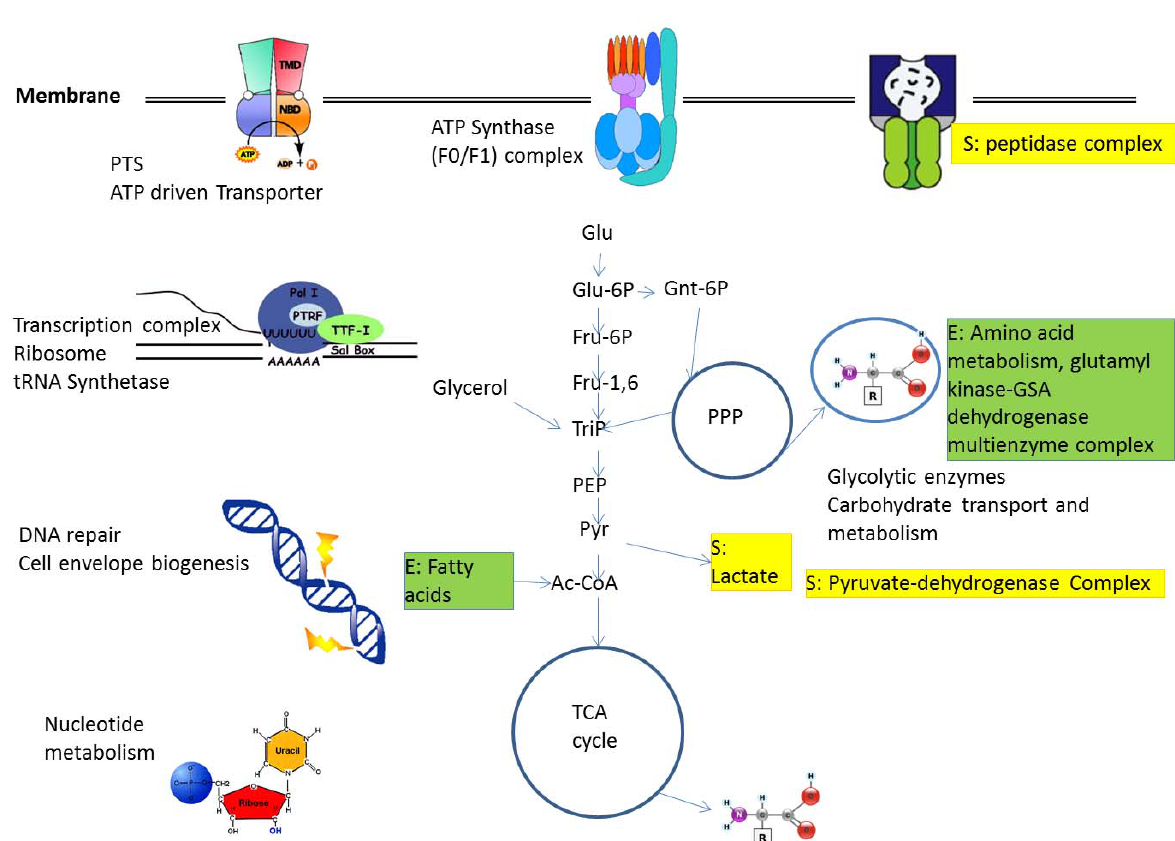
Figure 2. Protein complexes and their connection with metabolism. A number of central complexes are shown, giving the situation in E. coli , as well as implied and connected central metabolic pathways. In S. aureus , details of several complexes differ ( E. coli -specific complexes not present in S. aureus are labeled with E (in green), S. aureus -specific complexes not present in E. coli are labeled with S in yellow, see text). For details see